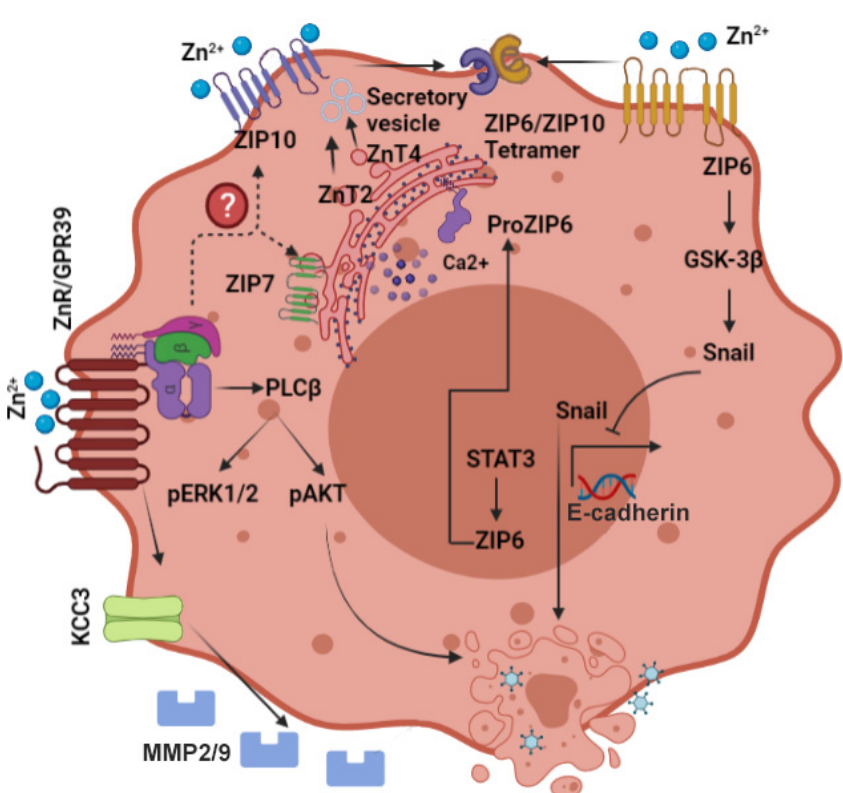
Figure 2. Scheme describing the activation of signaling pathways involved in breast cancer progression and metastasis. Zn 2+ dyshomeostasis results in activation of multiple pathways that affect cell morphology, migration, and proliferation. Note specifically ZIP10 and ZIP6 that interact to regulate epithelial mesenchymal transition, and ZnR/GPR39 that induces membrane protrusions and MMP2/9 release. Arrows depict established pathways, while dotted lines and question marks are putative pathways for regulation and interaction.